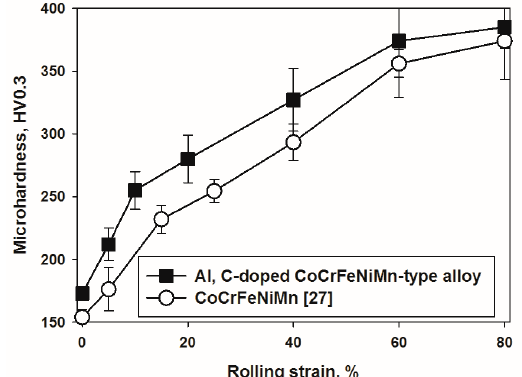
Figure 5. The dependence of microhardness of the Al-, C-containing CoCrFeNiMn-type alloy on rolling strain. Data for the equiatomic CoCrFeNiMn alloy [27] is shown for the comparison.